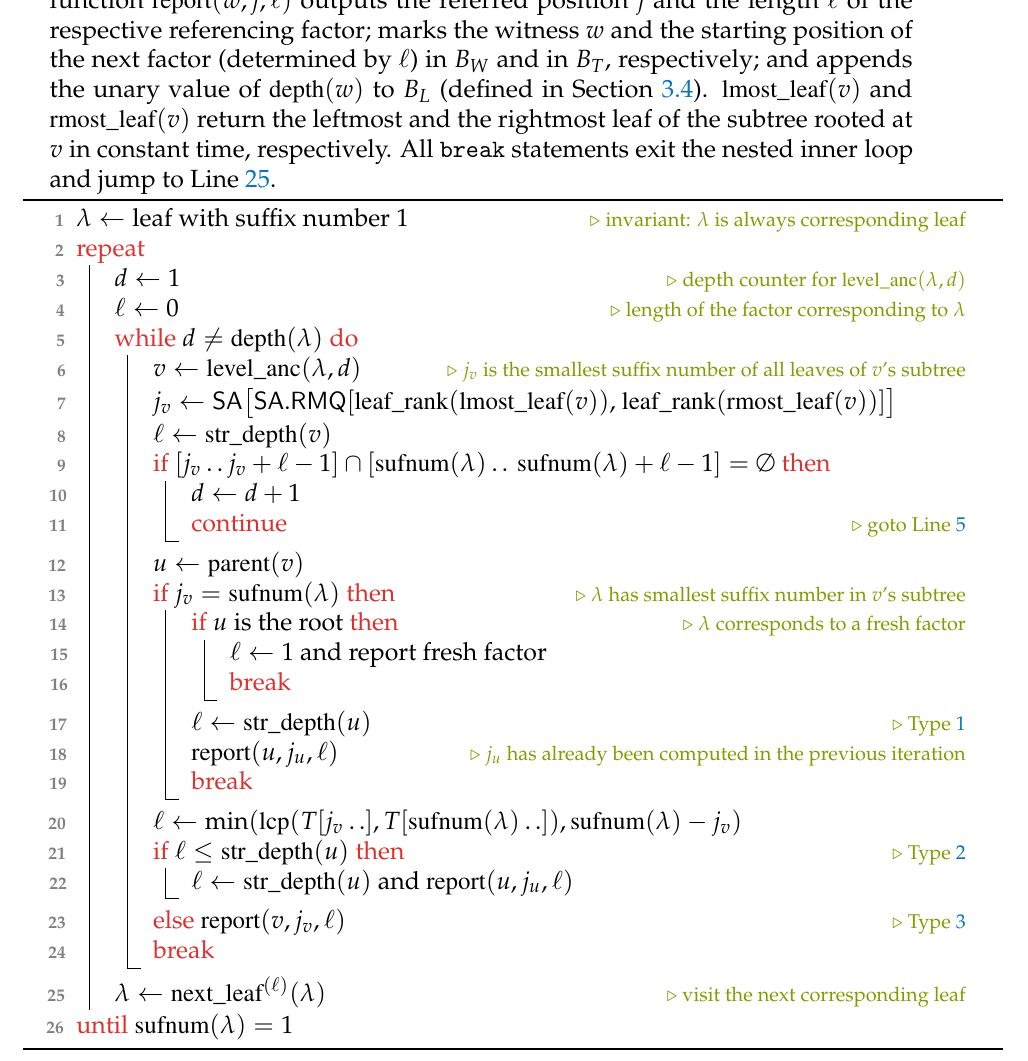
Algorithm 1: Pass (a) of the non-overlapping LZSS algorithm of Section 3.